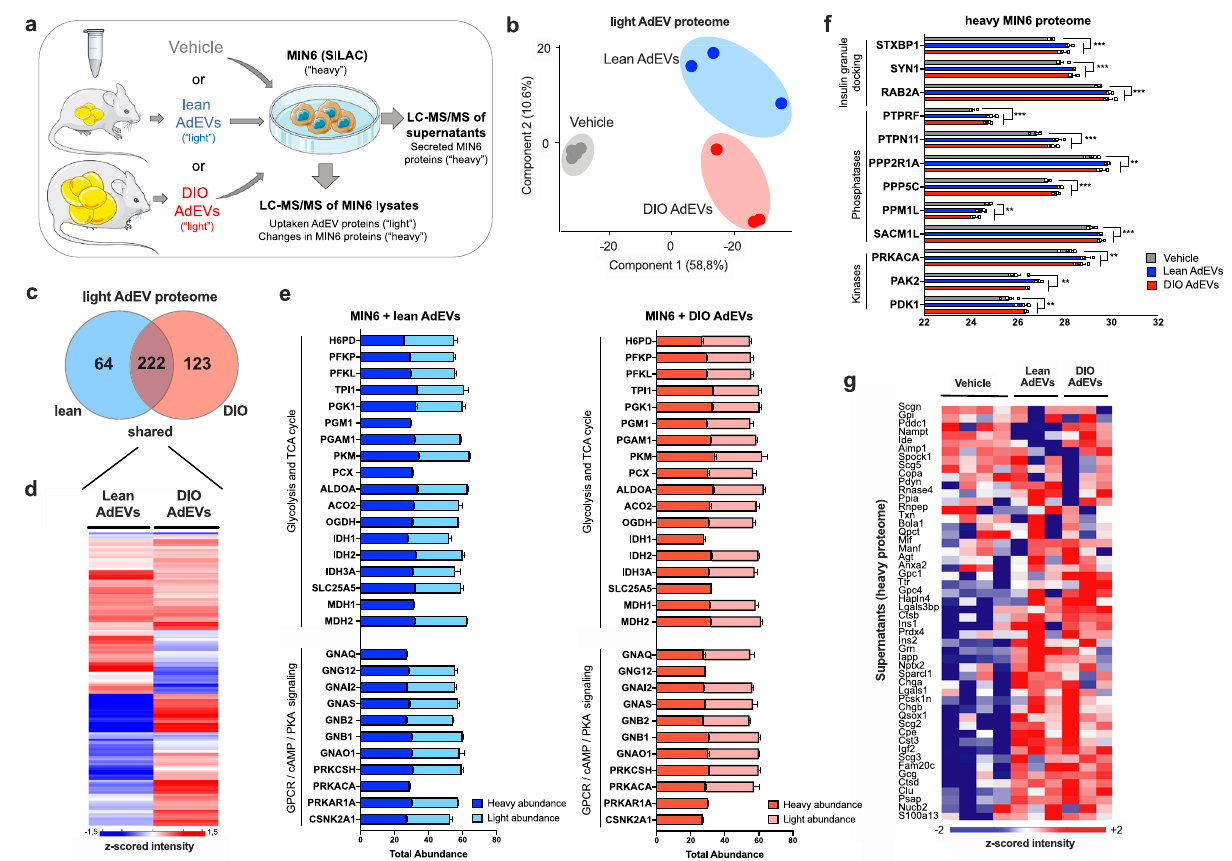
Fig. 3 | AdEV-mediated protein transfer into MIN6 cells. Proteomics of SILAC- labeledMIN6cellstreatedwithPBS(Vehicle)orAdEVsfromleanorDIOmice( n =3, biologicallyindependentAdEVsamples,eachisolatedfrompooledvisceralfatpads of 5 male C57BL/6J DIO mice, 6 – 8 months of age subjected to 4 – 6 months of HFD or chow, n =4 vehicle treated control samples). a Experimental setup. b PCA for “ light ” unlabeledproteins,and c Venndiagramrepresentingthenumberofdistinct vs. shared “ light ” unlabeled proteins transferred via lean or DIO AdEVs into MIN6 cells. d Heatmapforthe median of z-scored protein intensitiesforallshared AdEV- derived “ light ” proteins in MIN6 cells following subtraction of the median inten- sities of the vehicle group (baseline subtraction). e Total abundances of “ light ” AdEV-derivedproteinstransferredintoMIN6cellsviaexposuretoAdEVsfromlean (lightblue)orDIO(lightred)mice(baseline-subtracted),or “ heavy ” proteinsofthe SILAC-treated host cells after treatment with lean (dark blue) or DIO (dark red)